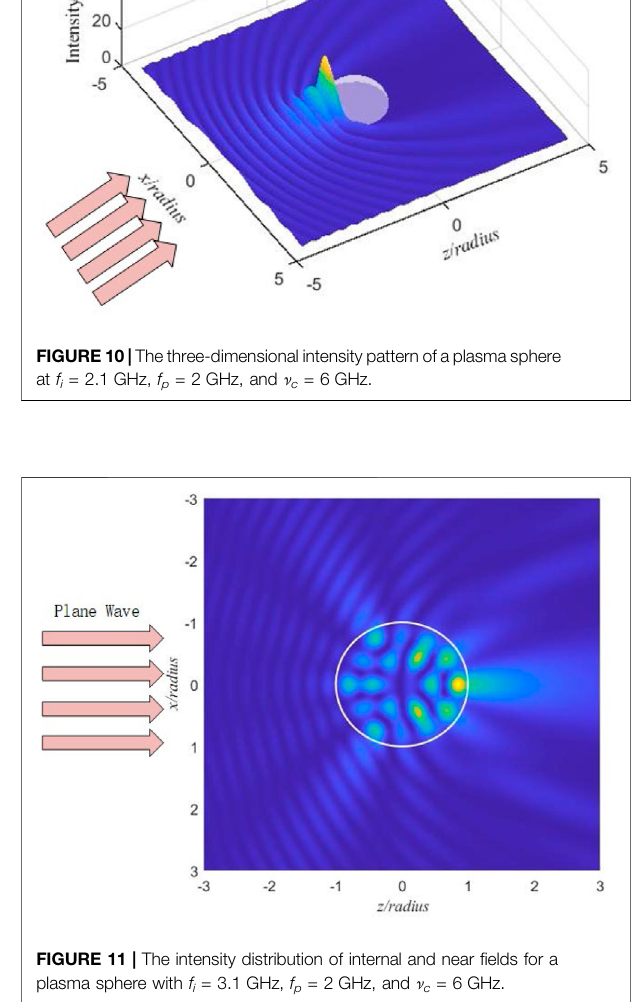
Frontiers in Physics |